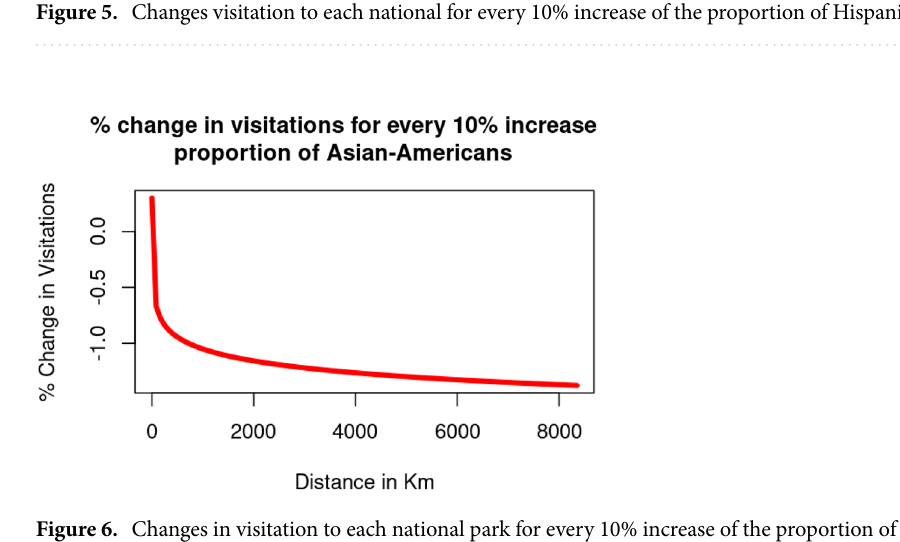
Figure 5. Changes visitation to each national for every 10% increase of the proportion of Hispanics.